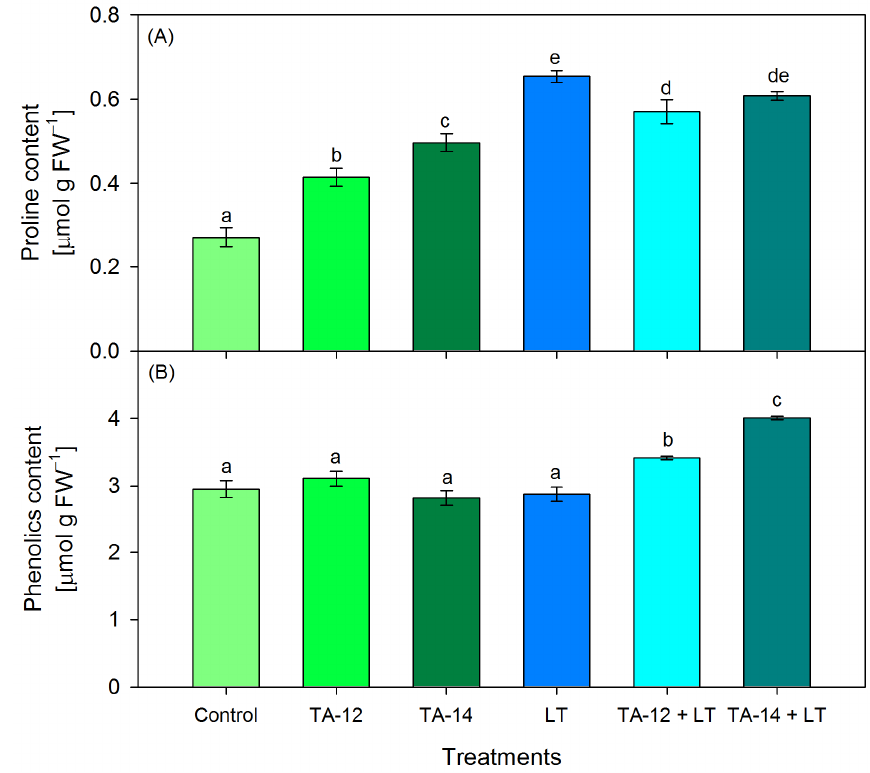
Figure 2. Content of proline ( A ) and total phenolics ( B ) in pea sprayed with TA-12 or TA-14 and subjected to low temperature (−1 °C, LT) for 24 h. Data are mean values ± SE. Different letters designate statistically significant difference at p < 0.05.